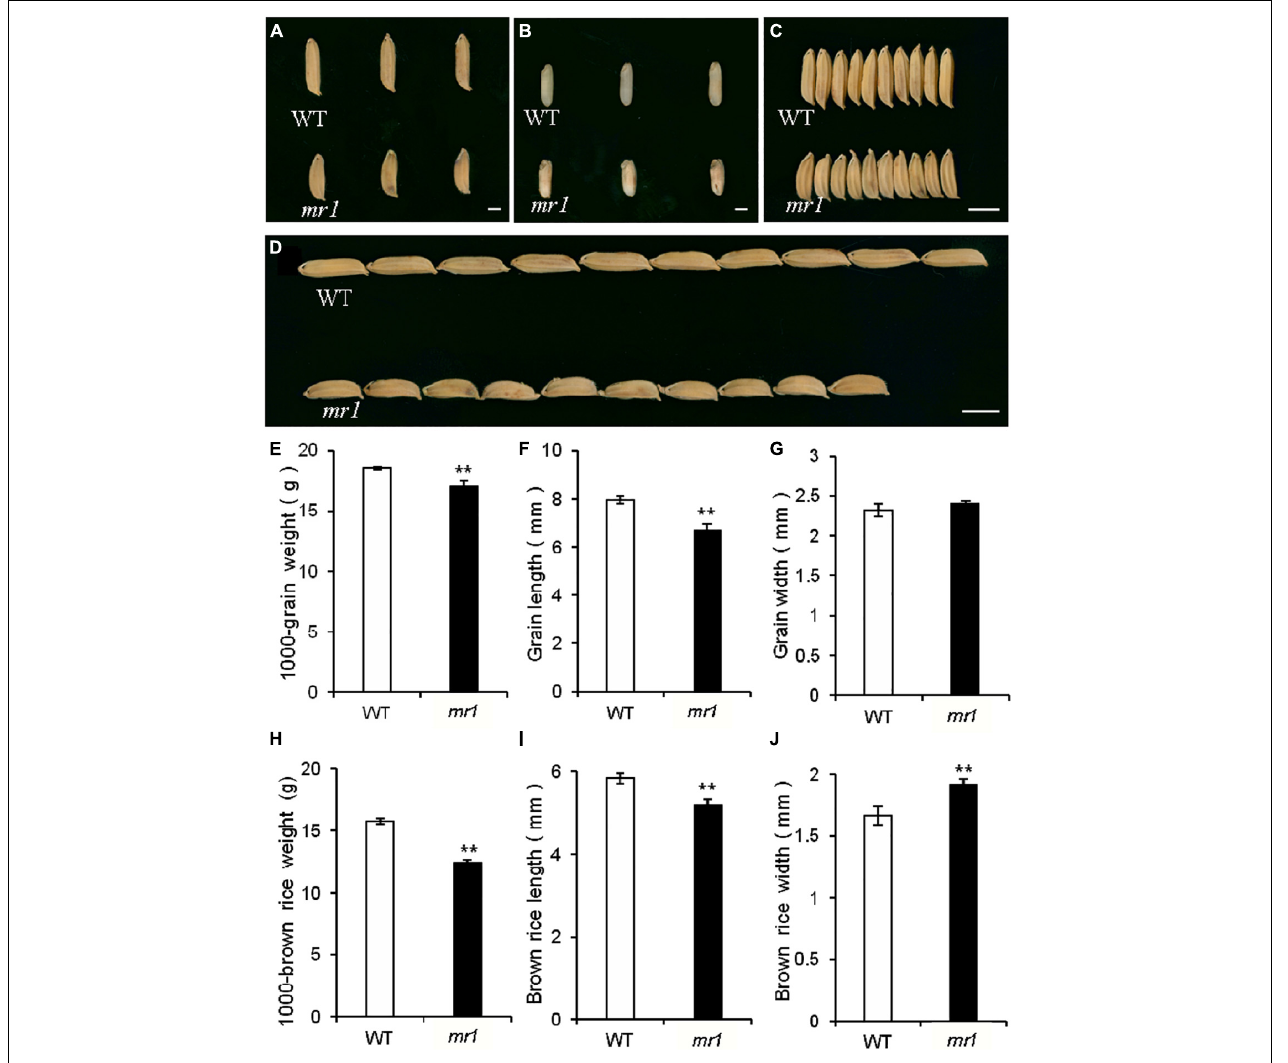
FIGURE 7 | Grains of the wild-type and the mr1 mutant. (A) Grains of the wild-type and mr1 mutant. (B) Brown rice of the wild-type and mr1 mutant. (C–D) Grains of the wild-type and mr1 mutant. (E–J) Length, width, and weight of grains and brown rice in the wild-type and mr1 mutant. Scale bar, 2 mm in (A,B) ; 5 mm in (C,D) . **Significant difference at p < 0.01 compared with the wild-type by Student’s t -test. Error bars indicate